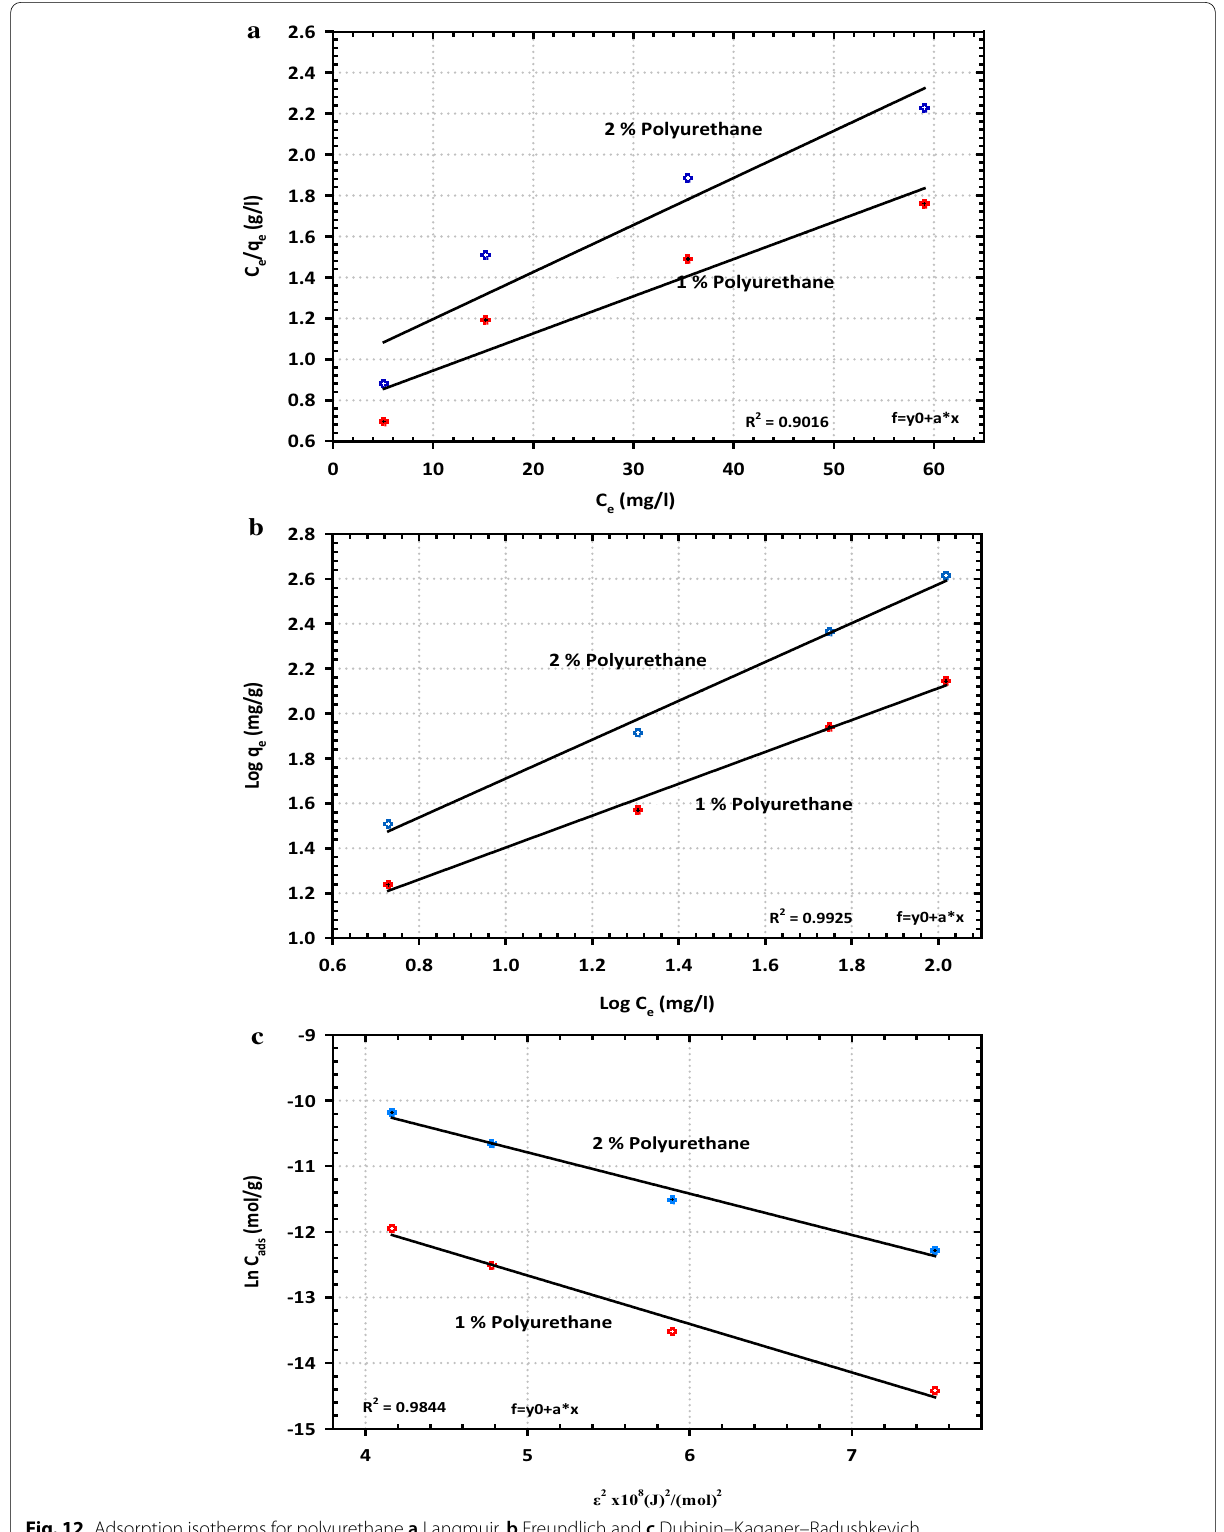
Fig. 12 Adsorption isotherms for polyurethane a Langmuir, b Freundlich and c